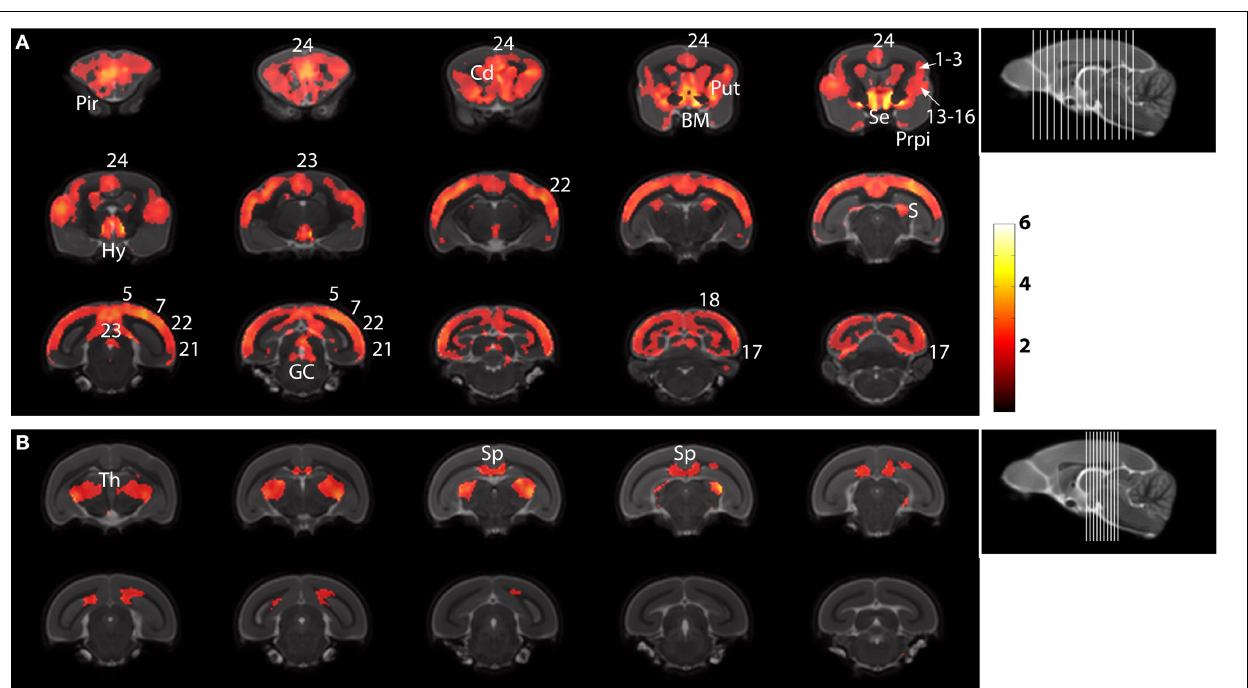
region (area 7), the temporal region (area 21), and the occipi- tal regions (areas 17 and 18) (all p < 0 . 05), and thus originating from various cortical